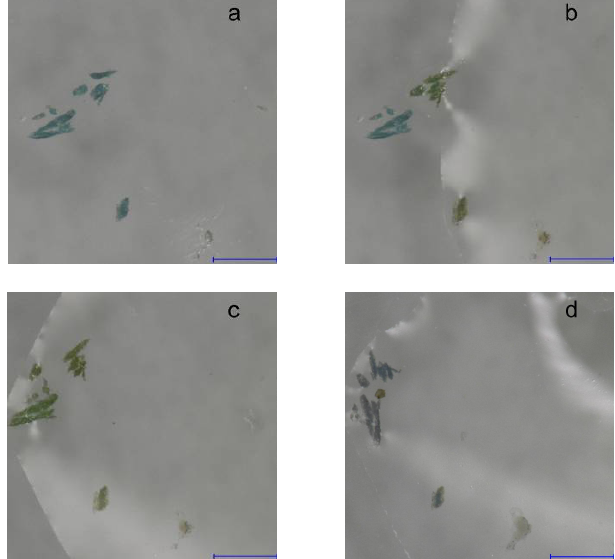
Figure 3. Images of the microchemical test on a blue paint sample. ( a ) The pigment before the test; ( b ) paint particles in contact with sulfuric acid; ( c ) color of particles has changed to yellow-green; and ( d ) after diluting the acid, the blue color returns. The scale bar is 250 µm.